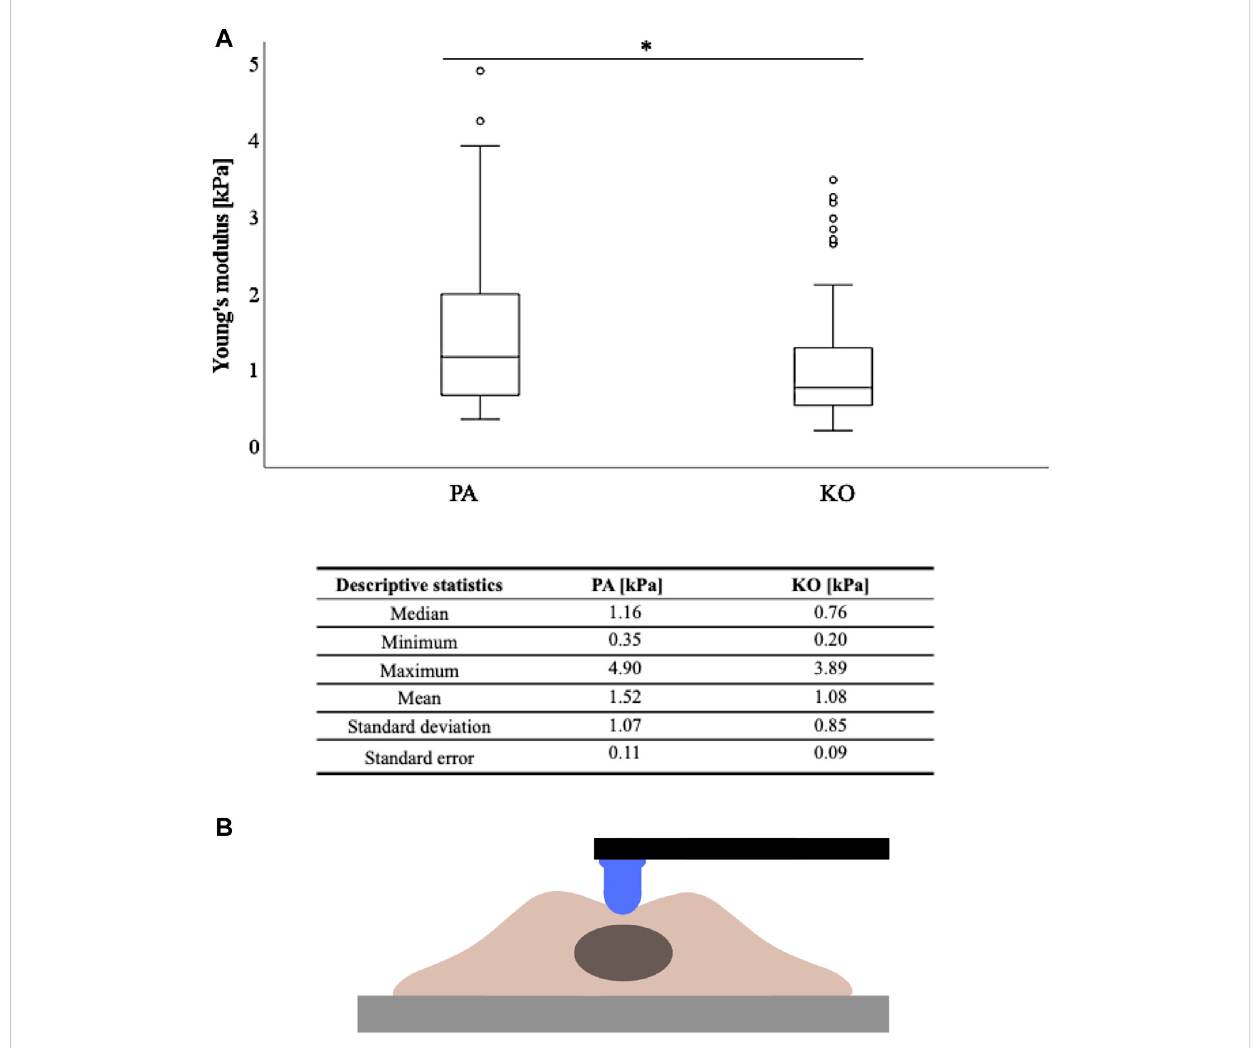
FIGURE 1 Microscopic images representing the regions of interest subjected to AFM measurements. (A) Cell lines A375 parental and A375 YB-1 knock-out, as well as MelJuso parental (Supplementary Figure S1), were subjected to AFM measurements. White arrows indicate the cantilever employed for indentation. Black arrows show the region of interest to be measured - an exemplary cell. (B) Schematic drawing of a single cell indented by a spherical AFMcantilever(5 µm).ImageswereacquiredwiththeinvertedAxioObserverD1lightmicroscopeattachedtotheAFMsystemat×10magni fi cation. The scale bar (black) represents 30 µm. Abbreviations: AFM - atomic force microscopy, PA - parental, KO -